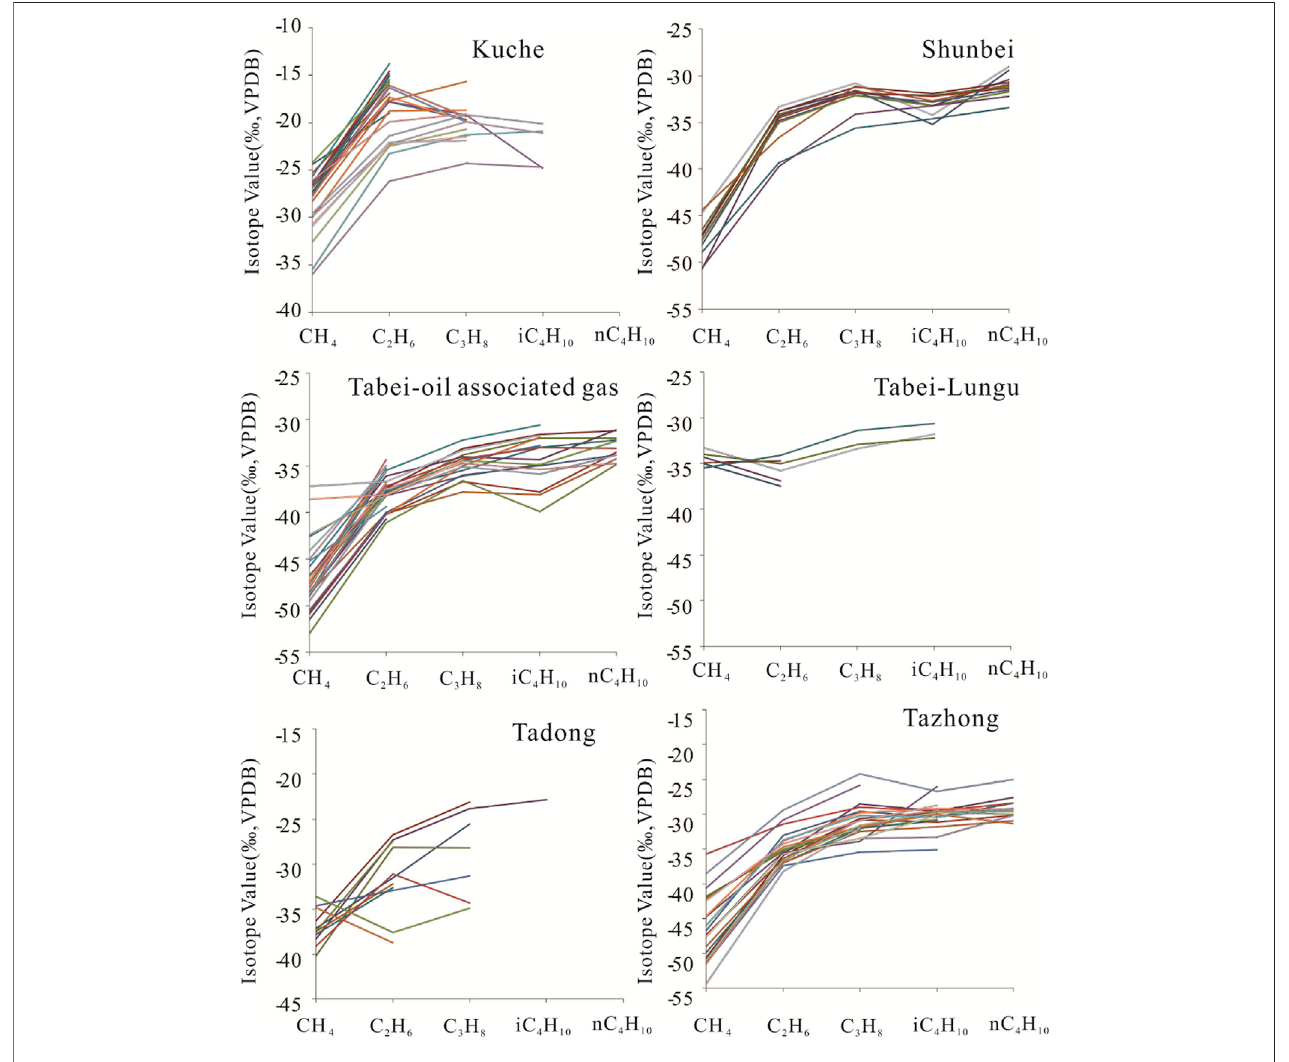
FIGURE 5 | Line chart of carbon isotope distribution of deep natural gas in